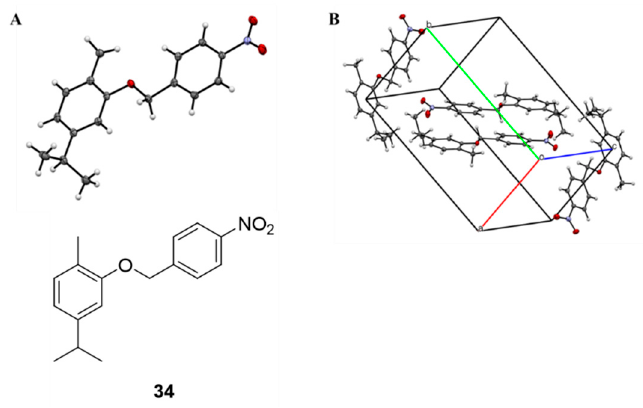
Figure 1. ( A ): ORTEP structure of compound 34 ; ( B ) Crystal structure of carvacrol-based compound 34.